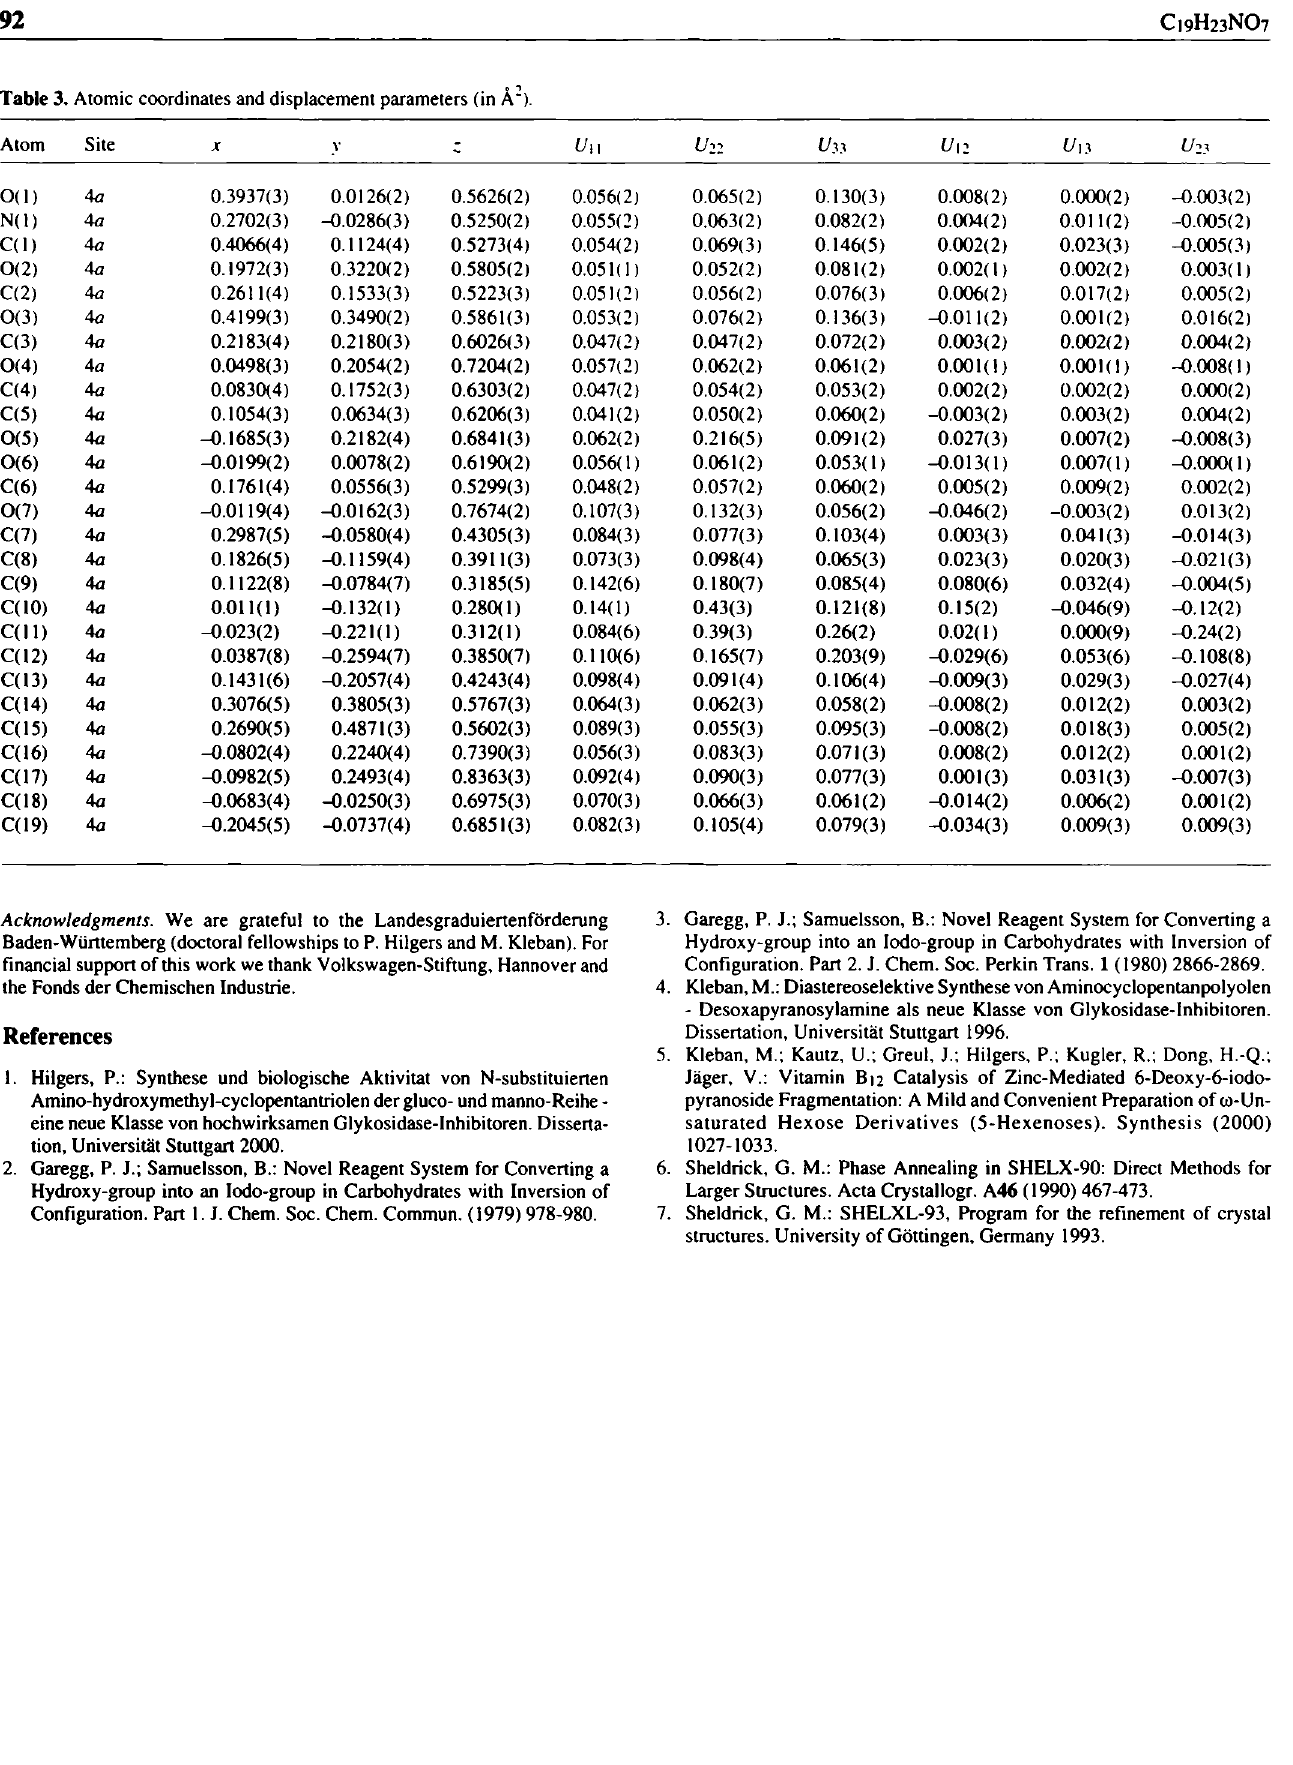
Table 3. Atomic coordinates and displacement parameters (in Ä 2